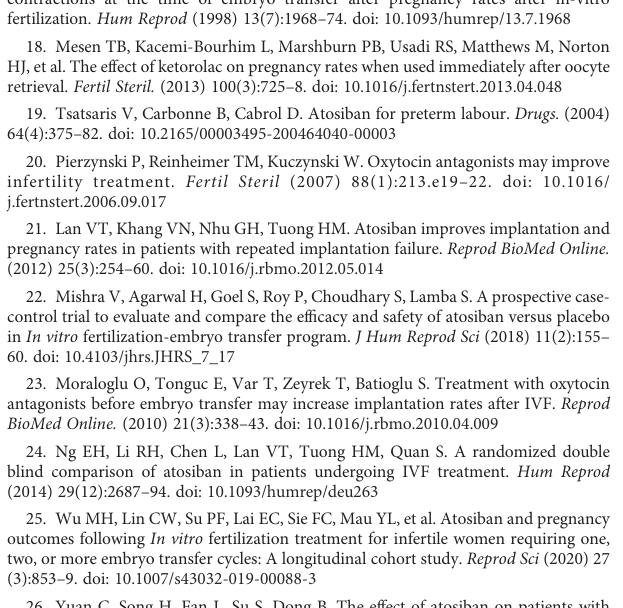
SUPPLEMENTARY FIGURE 1 Forest plots of positive pregnancy test rate.